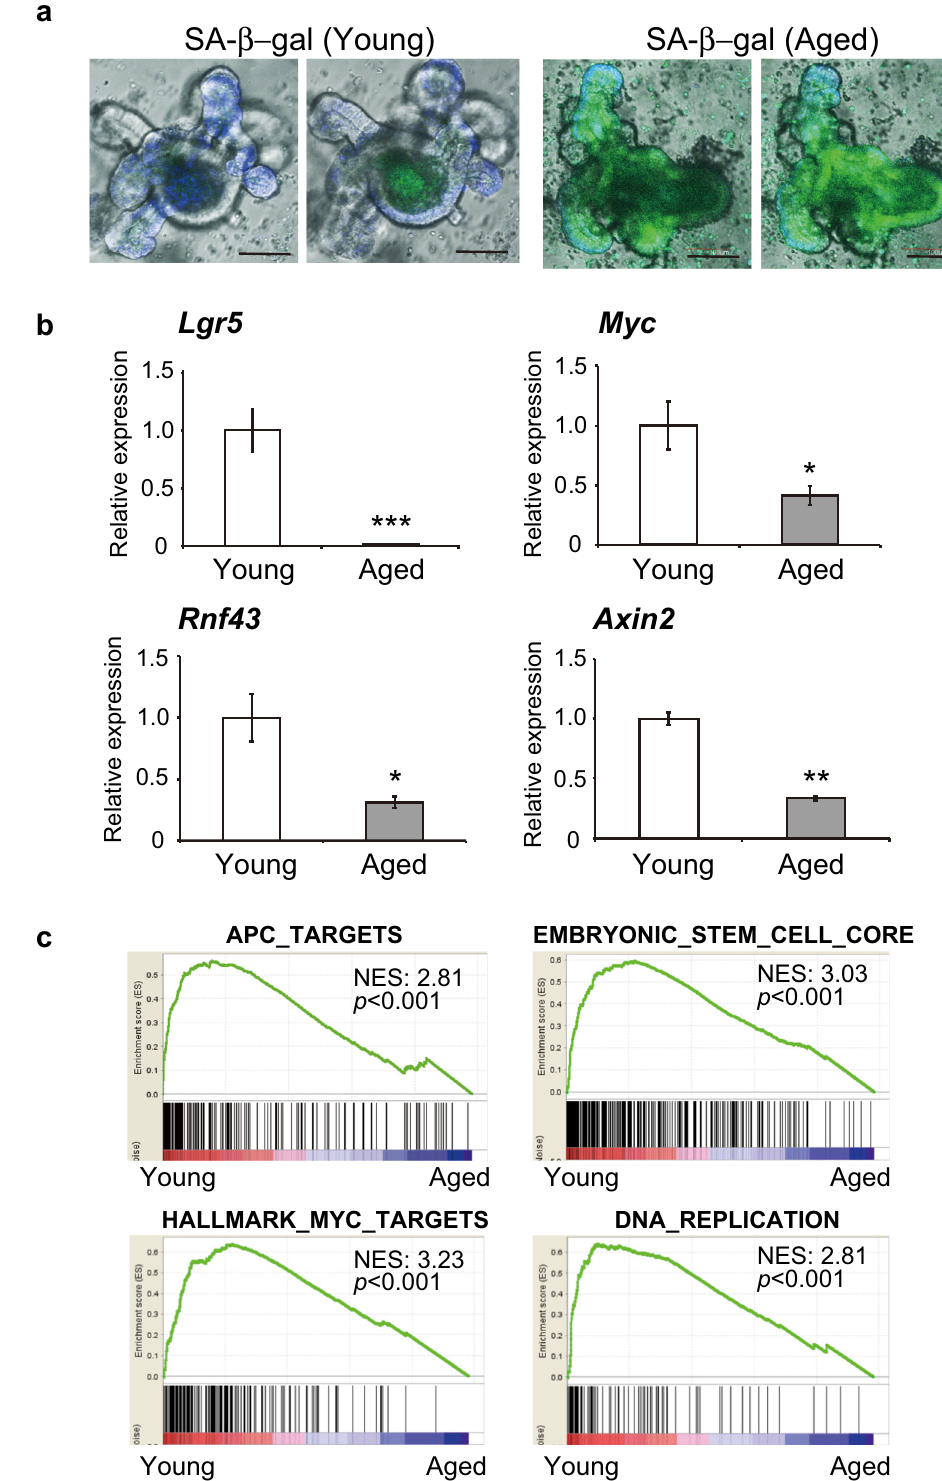
Fig. 2 Suppression of Lgr5 and the Wnt signaling pathway in intestinal epithelial organoids from aged mice. a Detection of SA- β -gal in intestinal epithelial organoids derived from young (6 weeks) and aged (78 weeks) mice. Accumulation of SA- β -gal was observed in aged intestinal epithelial organoids, whereas SA- β -gal was not detected in young organoids. Scale bars: 100 μ m. b Relative expression levels of Lgr5 and Wnt signaling pathway genes in intestinal epithelial organoids derived from young (4 weeks) and aged (54 weeks) mice. Results of 5 experiments were plotted as mean ± SD. * p < 0.05, ** p < 0.01, *** p < 0.001. c GSEA with the gene sets APC_TARGETS, EMBRYONIC_STEM_- CELL_CORE, HALLMARK_MYC_TARGETS and DNA_REPLICATION in intestinal epithelial organoids derived from young (4 weeks) and aged (54 weeks)